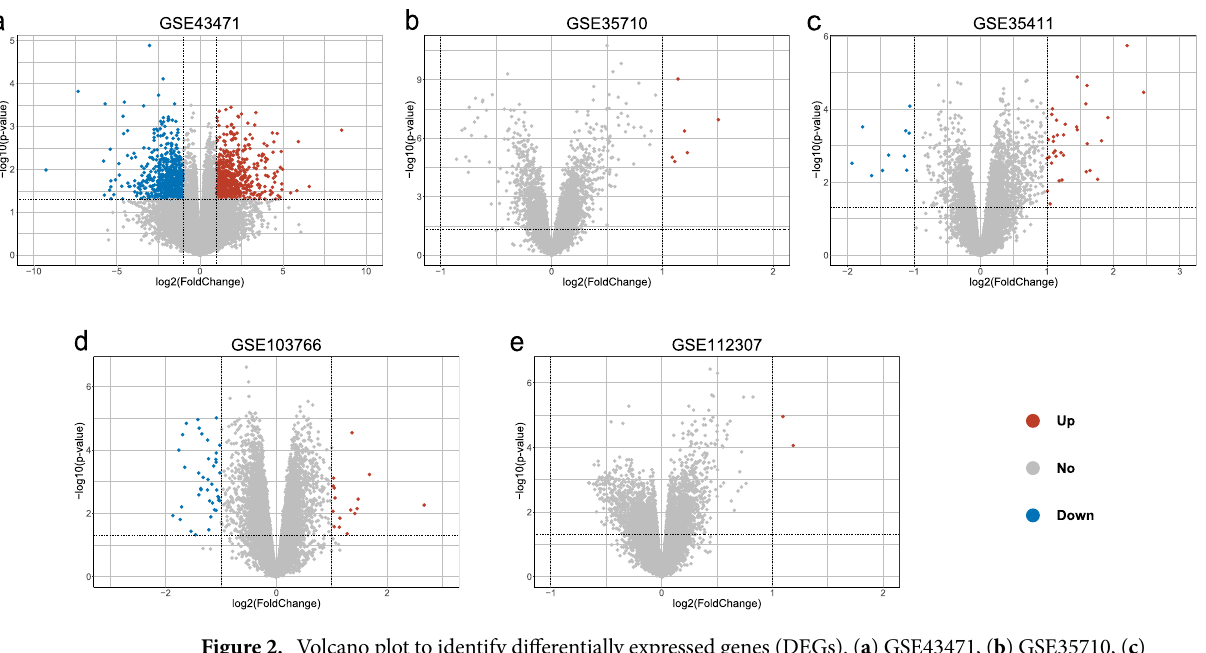
Figure 2. Volcano plot to identify differentially expressed genes (DEGs). ( a ) GSE43471, ( b ) GSE35710, ( c ) GSE35411, ( d ) GSE103766, ( e ) GSE112307. The x-axis label represents fold changes and the y-axis label represents the p -values. Red dots represent the 498 upregulated genes and green dots represent the 513 downregulated genes.